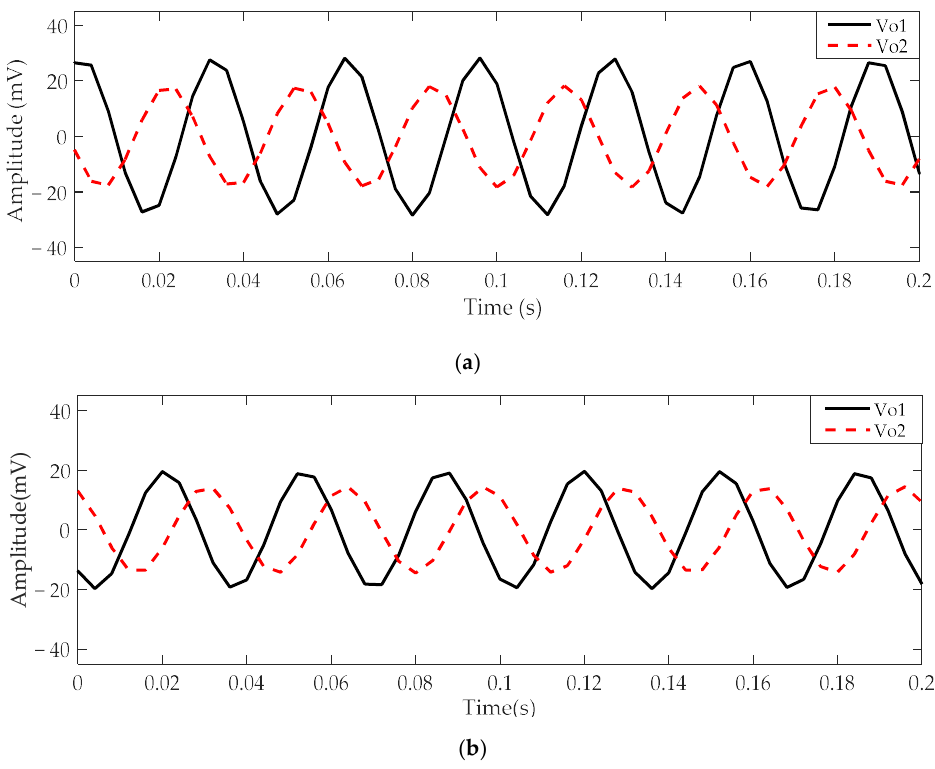
Figure 14. The output signals of V o1 and V o2 : ( a ) obtained when the rotor rotates clockwise; ( b ) ob- tained when the rotor rotates anti-clockwise.